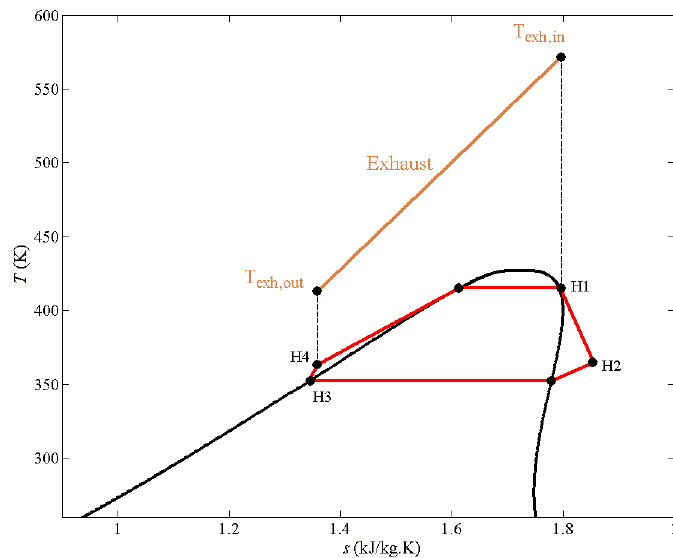
Figure 2. T - s diagram of the high-temperature (HT)